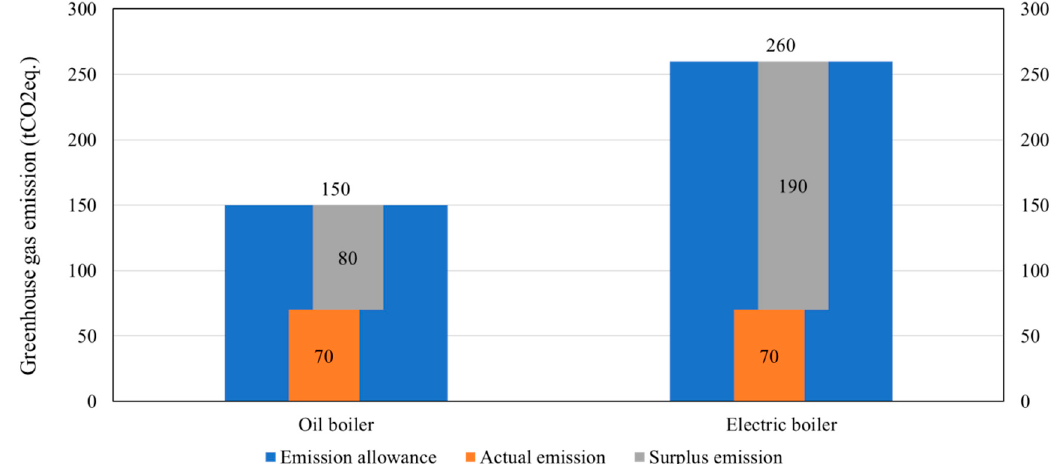
Figure 8. Greenhouse gas emission trading of proposed system.